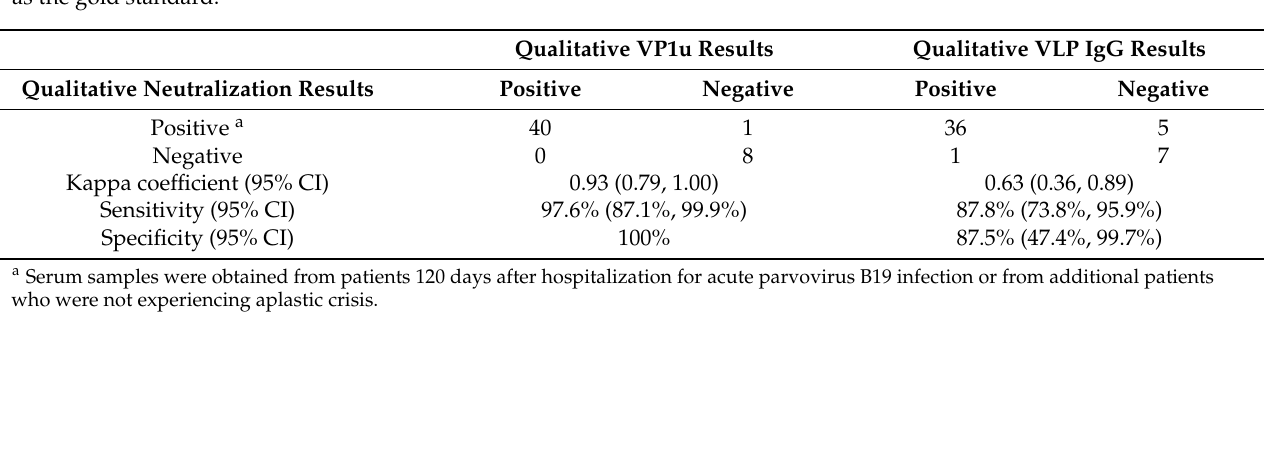
Table 2. Kappa coefficient, sensitivity and specificity of VP1uAT ELISA and VLP IgG ELISA with the neutralization assay as the gold standard.